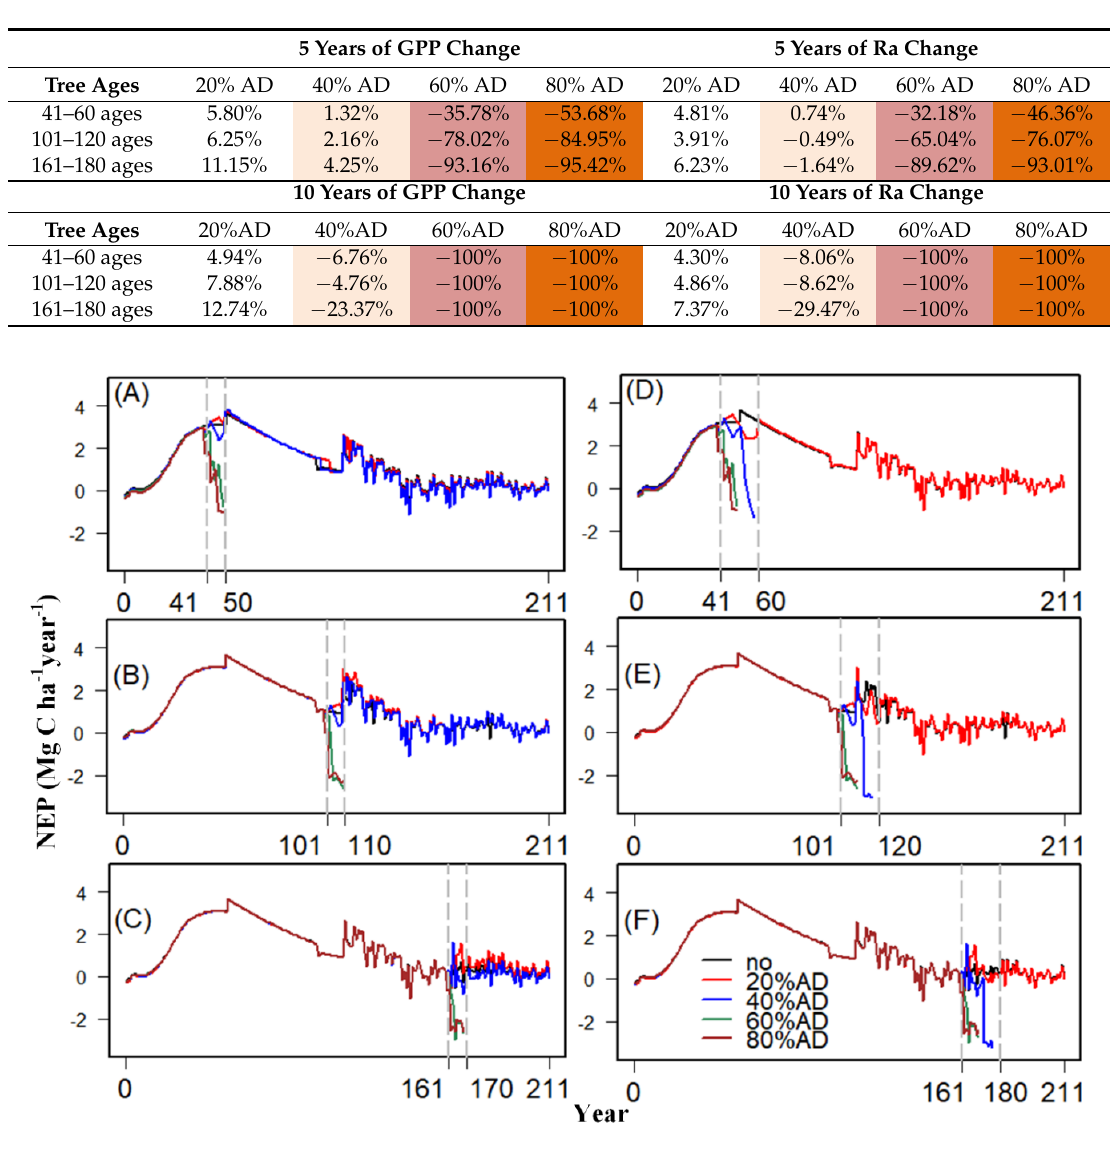
Figure 3. Simulated annual NEP started from different stand ages (41, 101 or 161 years) under two different durations of outbreaks (10 or 20 years) and five different defoliation scenarios (no defoliation (control), 20% AD, 40% AD, 60% AD, and 80% AD). AD denotes annual defoliation. ( A ) Short-Young;